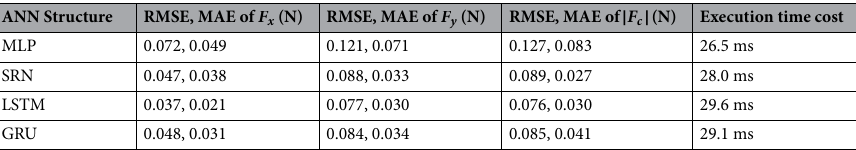
Table 1. A summary of estimator performance.